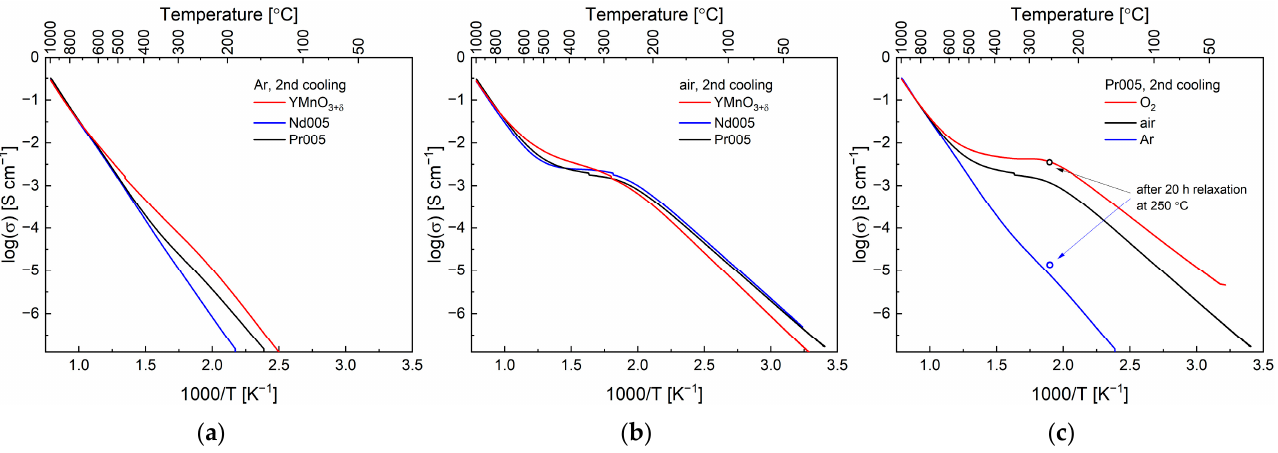
Figure 3. Total conductivity of YMnO 3+ δ , Nd005, and Pr005 in ( a ) Ar, ( b ) air, and ( c ) total conductivity of Pr005 in Ar, air and in O 2 as a function of temperature in Arrhenius-type coordinates. For Pr005, values of log( δ ) recorded after 20 h relaxation in Ar and in air (see Figure 4) are indicated with blue and black circles, respectively, for comparison. Table 3. Activation energy of the electrical conductivity evaluated for Pr005 sample in O 2 , air, and in